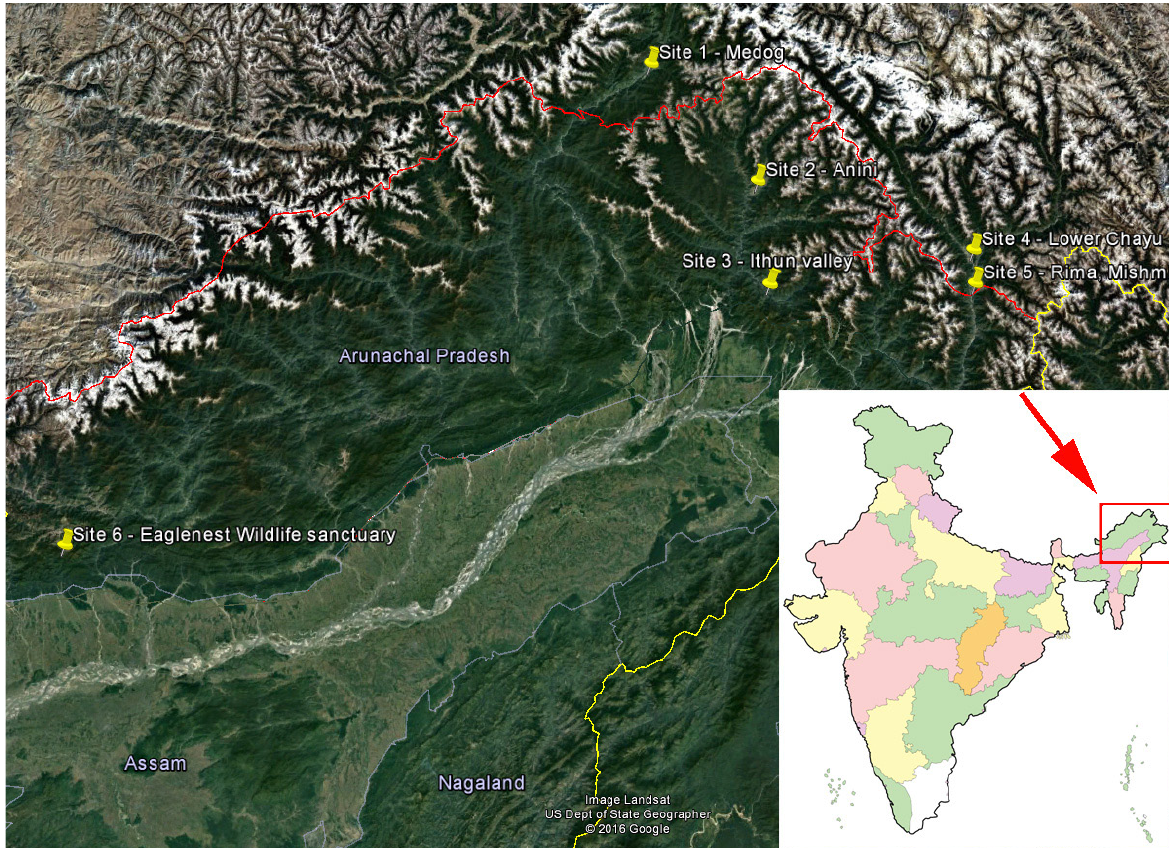
Figure 1. Recorded locations of Cigaritis zhengweilie In Arunachal Pradesh and adjacent Tibet. Insert by Rajeshodayanchal at Malayalam Wikipedia [CC BY-SA 3.0 (http://creativecommons.org/licenses/by-sa/3.0)], via Wikimedia